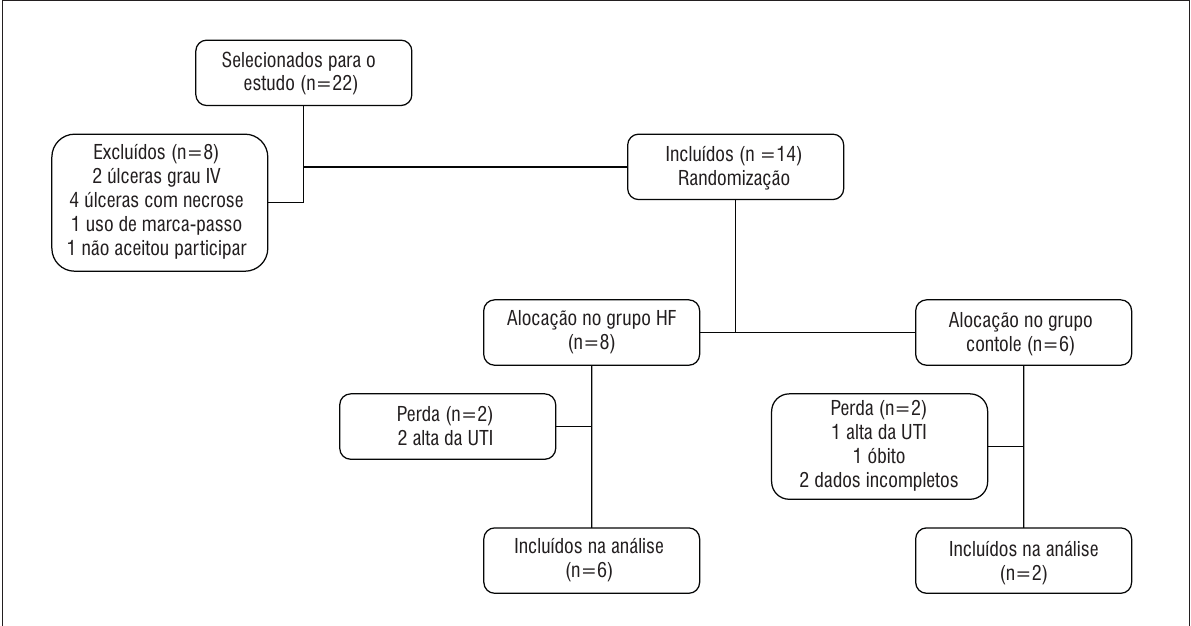
Figura 4 – Seleção, randomização e análise dos voluntários para o estudo Fonte: Dados da